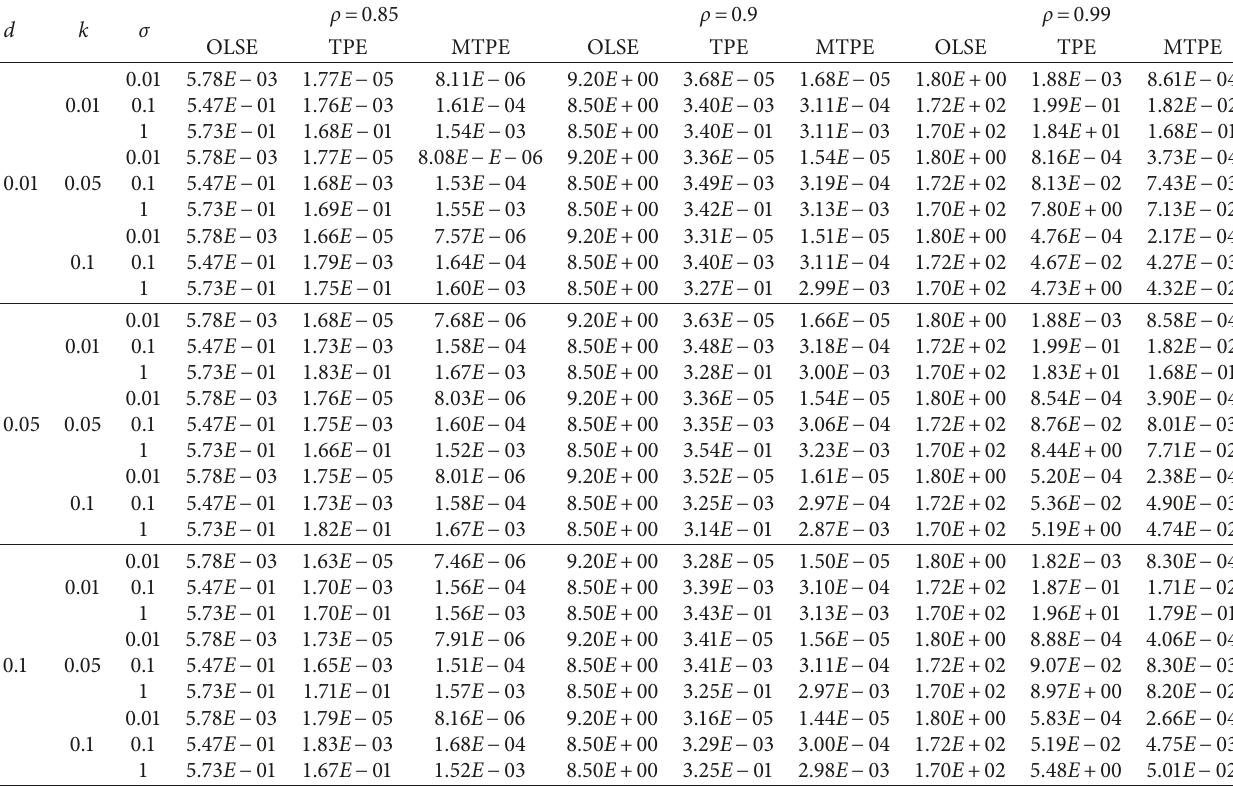
Table 6: Estimated MSE values of the OLSE, TPE, and MTPE when n �